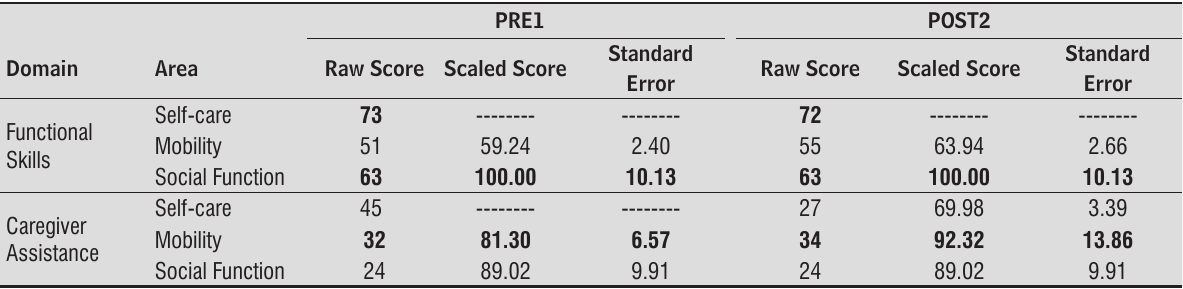
Table 3 - Comparative data on the composed scores of PEDI questionnaire, in the assessments before (PRE1) and after the intervention period (POST2) PRE1 POST2 Domain